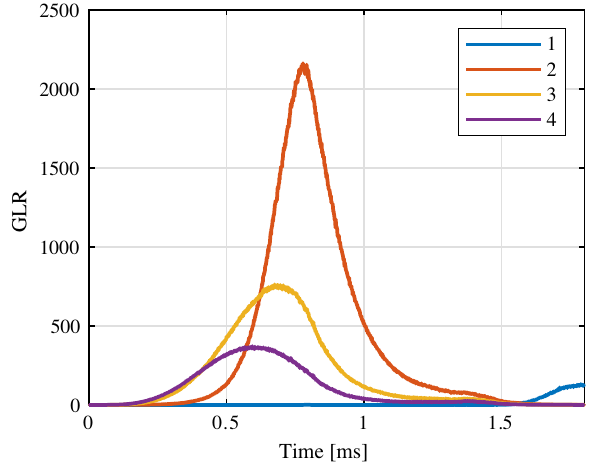
FIG. 6. GLR values of quenches for the four consecutive pulses after exceeding the threshold.